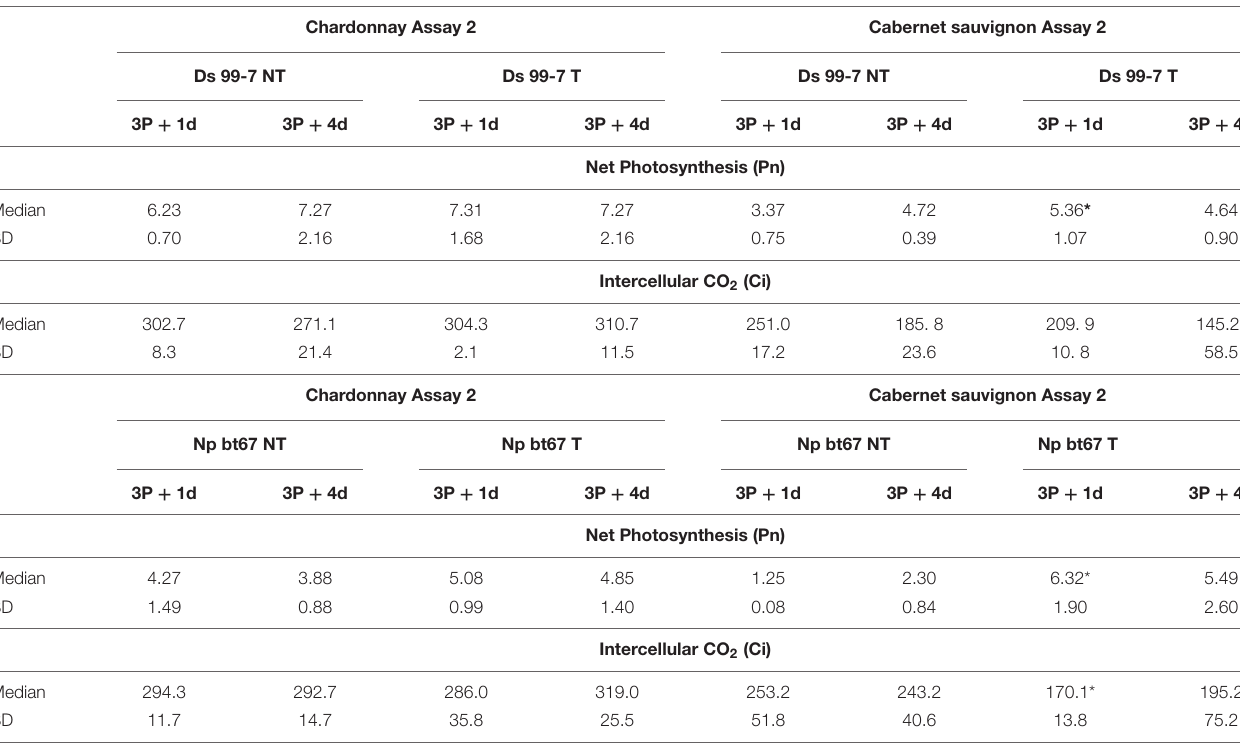
TABLE 6 | Photosynthetic parameters (Pn, Gs, Ci, and Tr) recorded during Assay 2 one ( + 1 d) and four ( + 4 d) days after the treatments on non-inoculated grapevines “Chardonnay” and “Cabernet